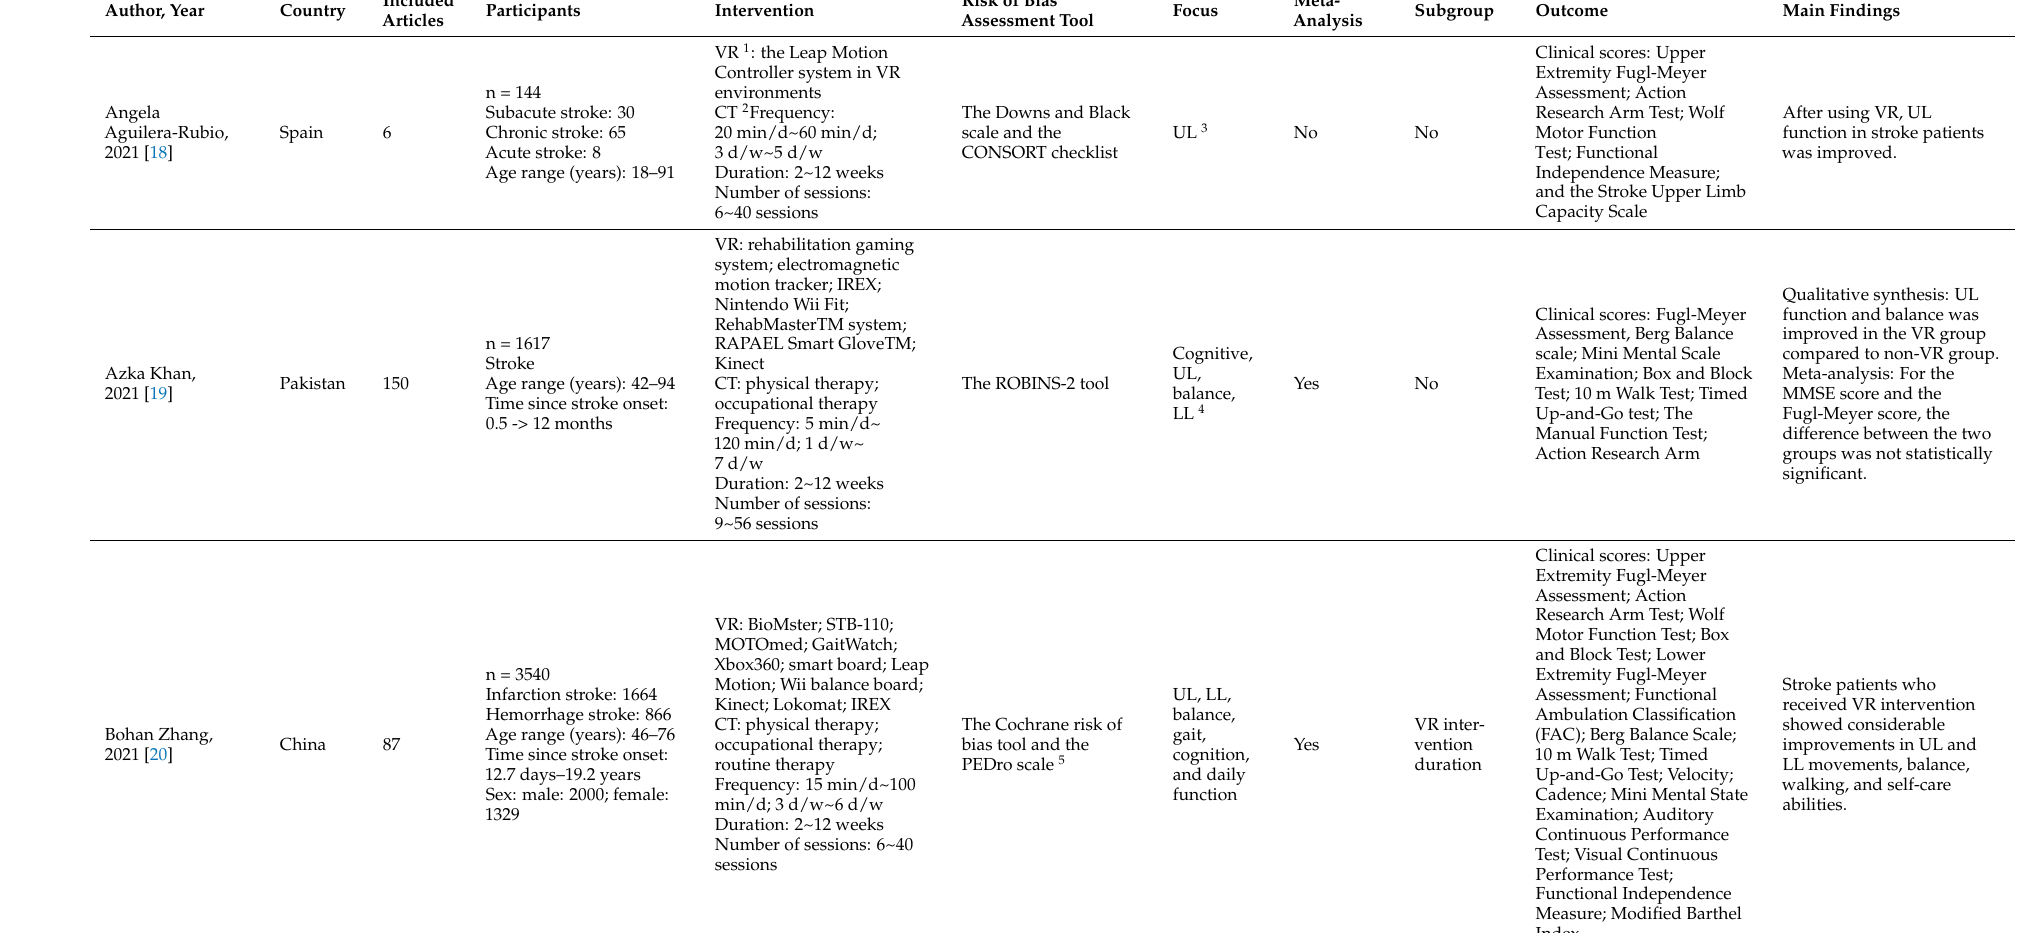
Table 2. Characteristics of the included systematic reviews (n =